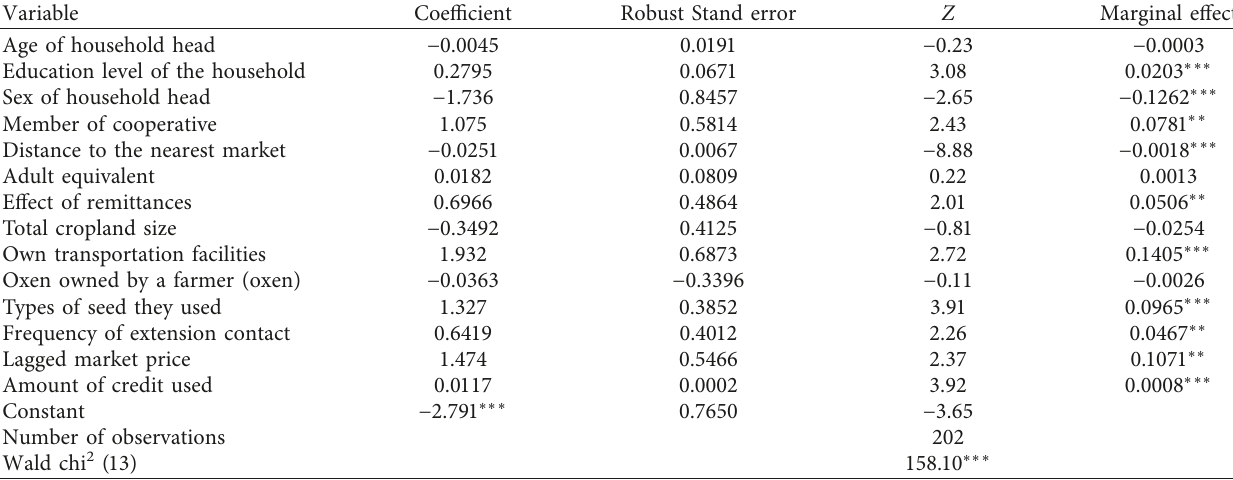
Table 3: First-stage probit estimation after robust results of the determinants of potato market participation.